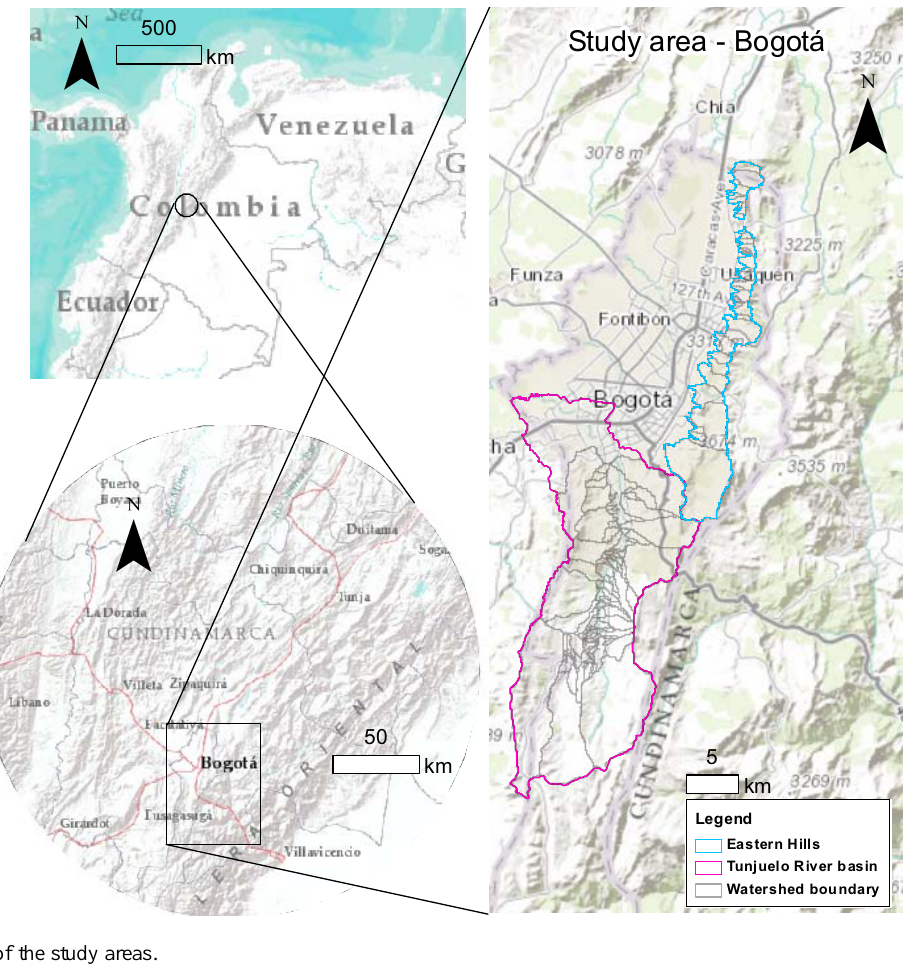
Figure 1. Location of the study areas. Table 1. Most severe recent flooding events in the study